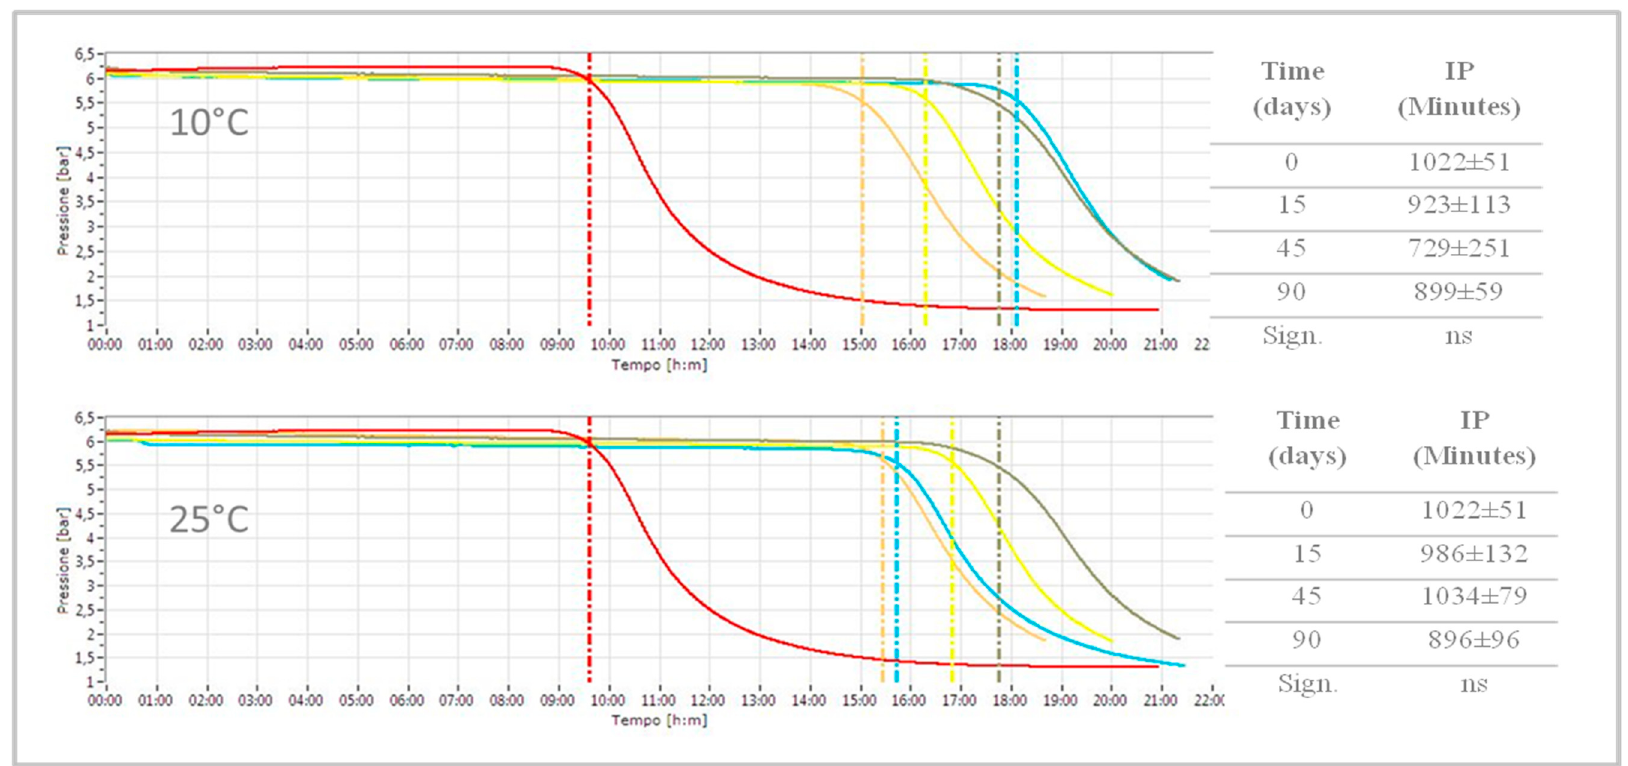
Figure 2. Oxidation curves during storage at 10 and 25 °C: red (sunflower oil), green (Mboil at 0 days), yellow (Mboil after 15 days), blue (Mboil after 45 days) and orange (Mboil after 90 days). ns: not significant.